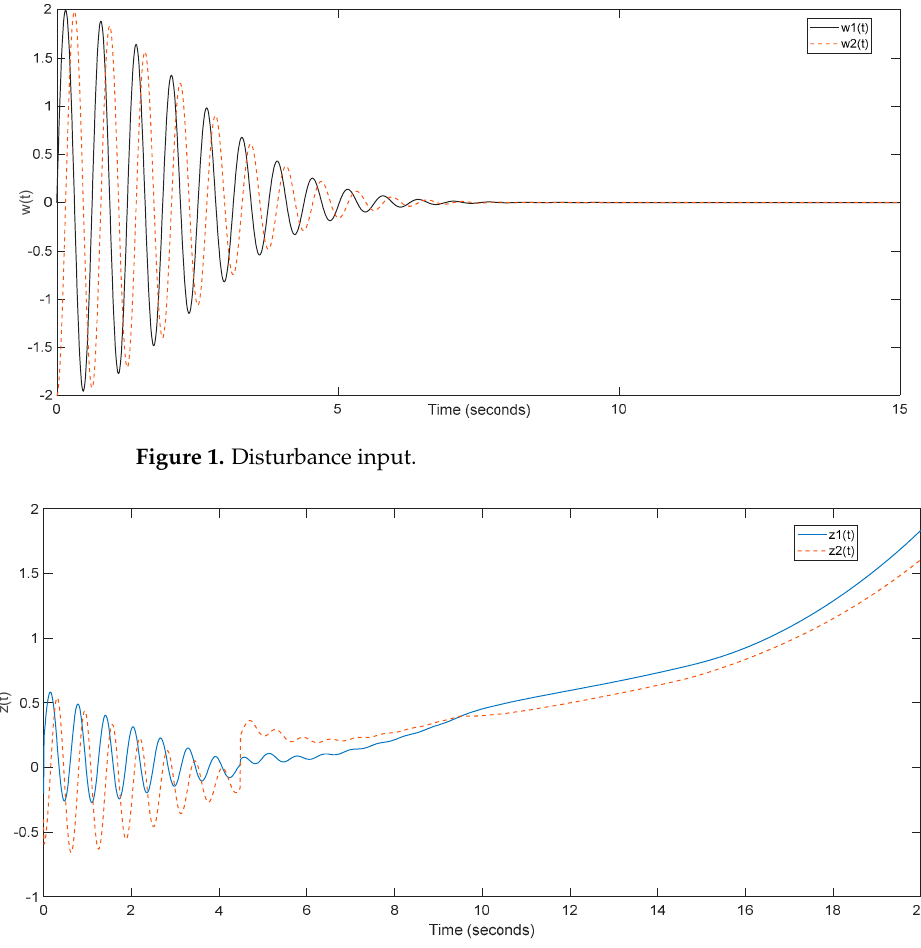
Figure 1. Disturbance input.